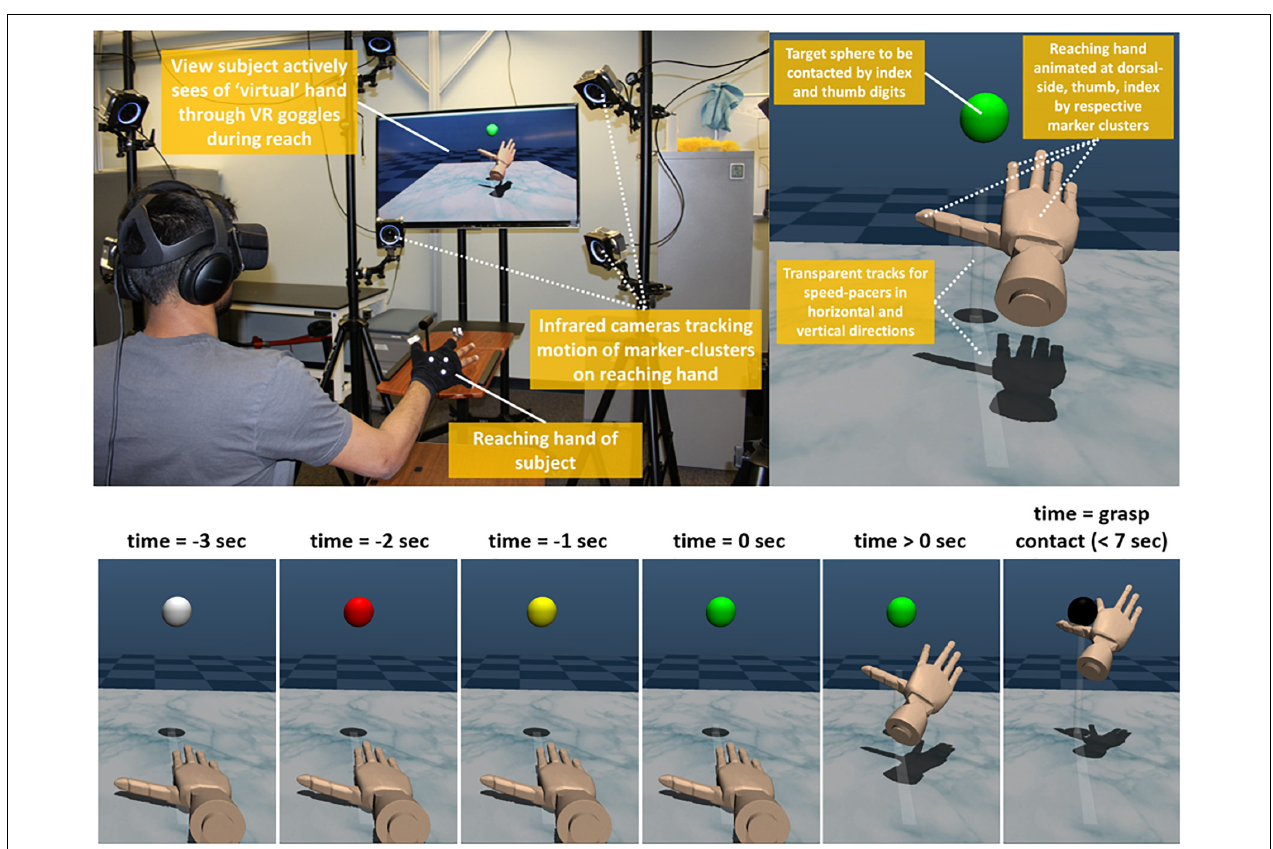
FIGURE 3 | Virtual reality environment. ( Top Left) Participant actively reaches and concurrently views virtual hand, ( Top Right) Close-up of virtual hand reaching to target sphere against transparent speed pacer tracks, Bottom) Sphere color changes with hand transitions across trial time t = –3 to +7 s (10 s total). Countdown occurs from t = –3 to 0 s. After countdown, hand should be in “motion” during time sphere is